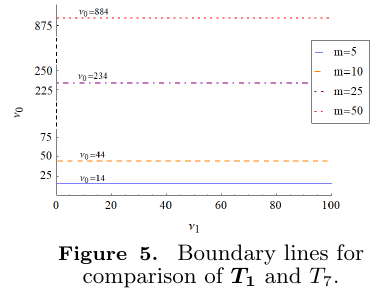
Figure 5. Boundary lines for comparison of T 1 and T 7 .